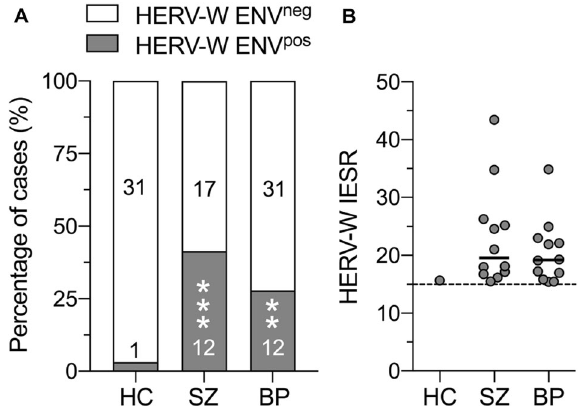
Fig. 1 HERV-W envelope protein antigenemia in healthy controls (HC), patients with schizophrenia (SZ) and patients with bipolar disorder (BP). A Relative frequency distribution (depicted as percentage of cases) of HC, SZ and BP subjects who are negative (HERV-W ENV neg ) or positive (HERV-W ENV pos ) for HERV-W envelope protein. The embedded numbers re fl ect the number of subjects in each category. ** p < 0.01 and *** p < 0.001, based on Chi-square test. B Quantity of HERV-W ENV soluble antigen in sera of HERV-W ENV pos HC, SZ and BP subjects, expressed as “ inter-experiment standardized result ” (IESR). The dashed line indicates the cut-off value of 15 IESR. Values above and below this threshold were considered as positive and negative, Fig. 1A, more than 96% (31 out of 32) of the HC subjects were negative for HERV-W ENV protein (HERV-W ENV neg ), while only 1 out of 32 HC subjects was positive (HERV-W ENV pos ). By contrast, 41.4% (12 out of 29) and 58.6% (17 out of 29) of the SZ cases were HERV-W ENV pos and HERV-W ENV neg , respectively (Fig. 1A), leading to a signi fi cant difference in the number of cases with detectable HERV-W ENV protein levels between HC and SZ subjects ( χ 2 = 13.28, z = 3.64, p < 0.001). Likewise, there was a signi fi cant difference in the number of cases with detectable HERV-W ENV protein between HC and BD subjects ( χ 2 = 7.86, z = 2.80, p < 0.01). In the latter group, 27.9% (12 out of 43) of BD cases were HERV-W